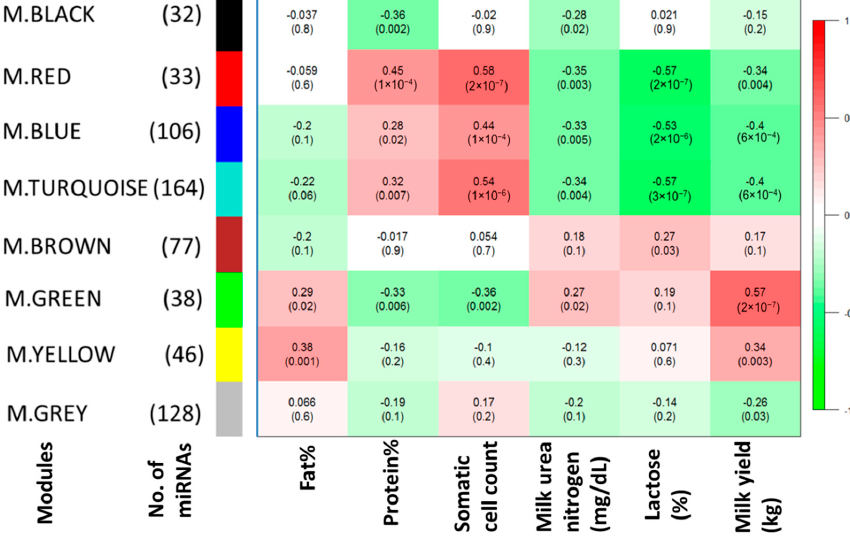
Figure 1. Module trait relationship: A matrix with the Module-Trait Relationships (MTRs) (correlation coefficients) and corresponding p-values (in brackets) between modules on the y-axis and lactation traits on the x-axis. The MTRs are colored based on their correlation: red is a strong positive correlation, while green is a strong negative correlation.